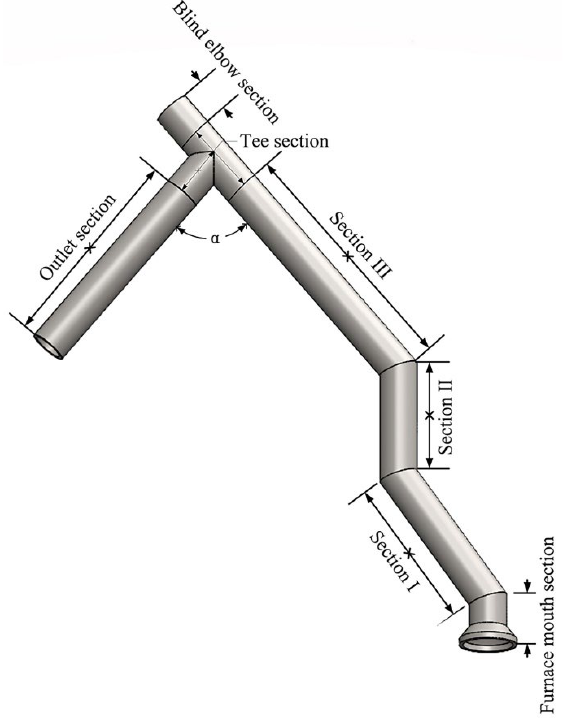
Figure 2. Schematic diagram of flue structure. Table 1. The parameters used by the model .